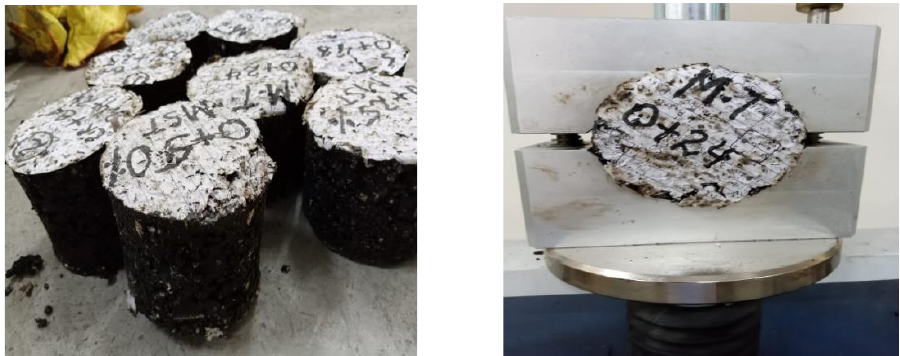
Figure 8. Asphalt concrete specimens prepared and tested for Marshall stability and flow.